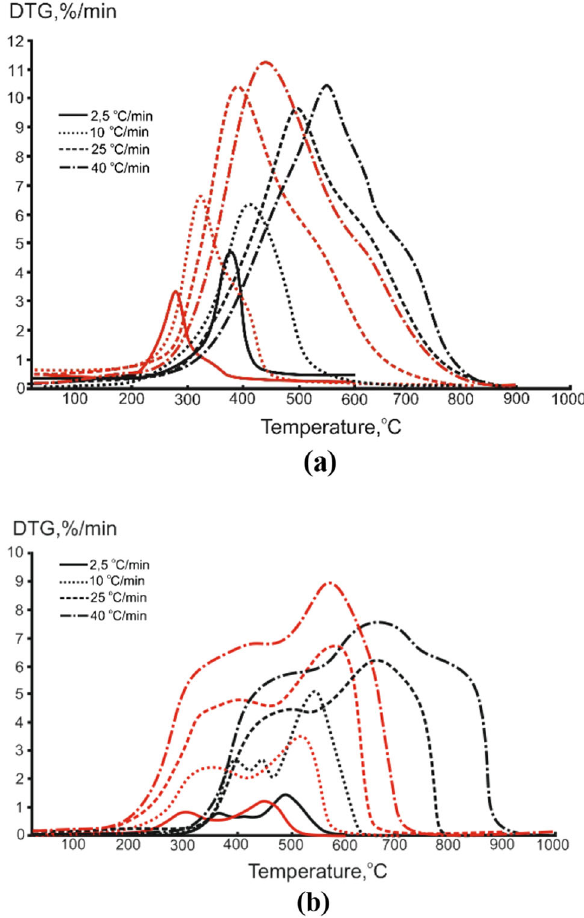
Fig. 8 DTG-curves for the oxidation of the coal samples at different heating rates. a L series samples; b B series samples. Initial samples are denoted by a black line, the modified samples are denoted by a red